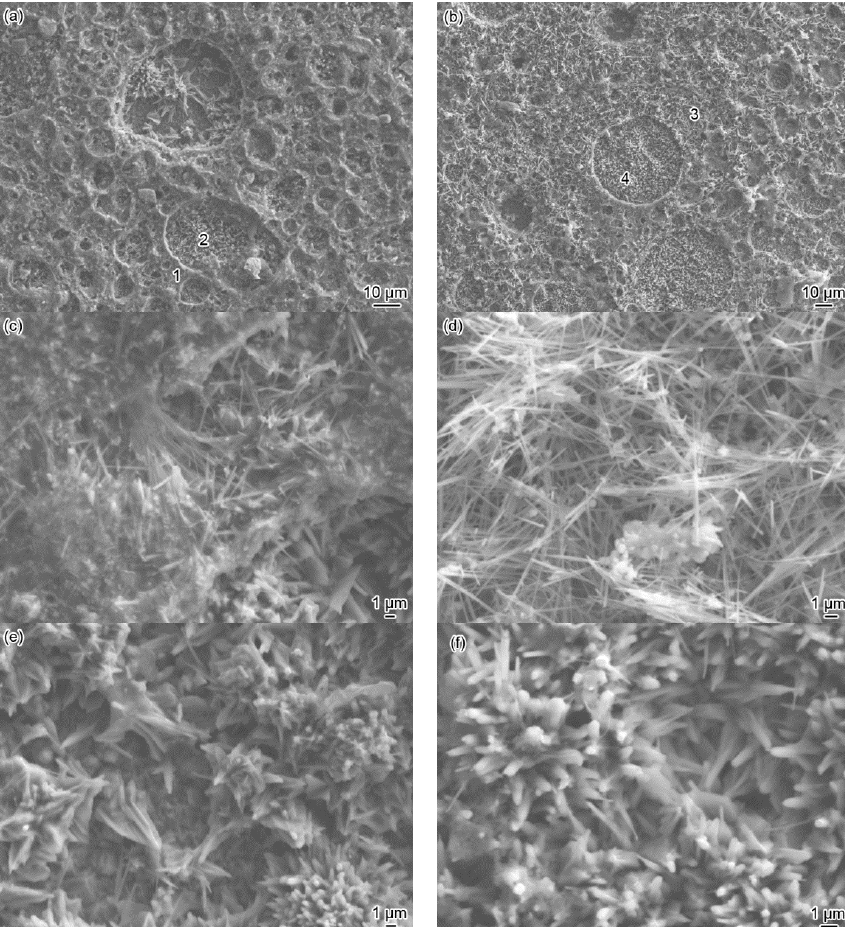
Figure 9. SEM surface morphologies of corrosion scales on the Ni-based alloy coating before ( a , c , e ) and after pickling ( b , d , f ) exposed to the H 2 S/CO 2 environment for 360 h at 140 °C: ( c , e ) high magnification images of ( a ) denoted by 1 and 2, respectively and ( d , f ) high magnification images of ( b ) denoted by 3 and 4, respectively.